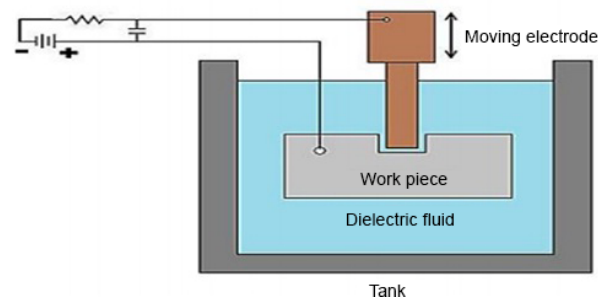
Figure 2. Overcut (Habib and Samesh,